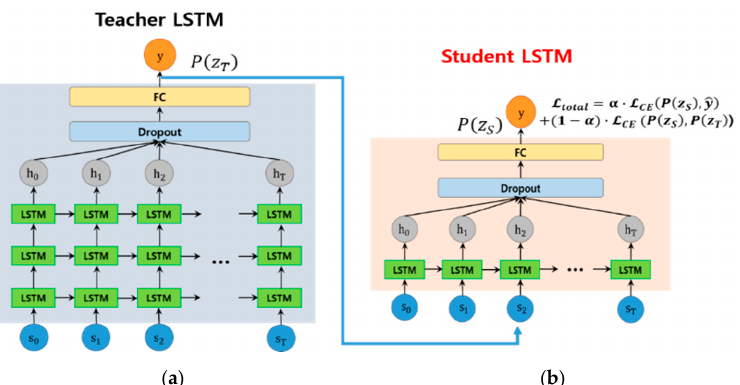
Figure 6. The proposed teacher–student framework for constructing a shallow student LSTM, ( a ) a teacher LSTM consists of three layers and ( b ) a shallow student LSTM consists of a single layer.